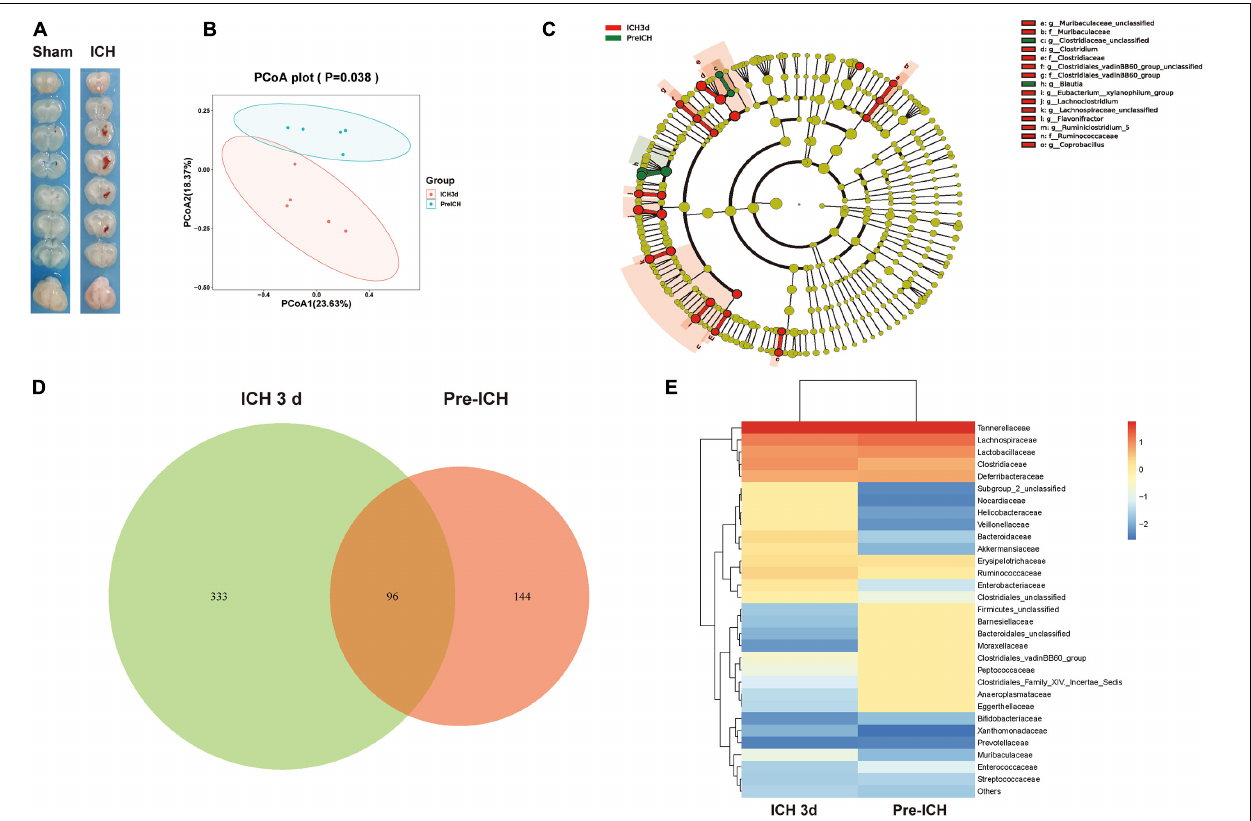
FIGURE 1 | Gut microbiota alterations after intracerebral hemorrhage in mice. (A) Images represented of sham and ICH coronal brain sections 3 days after ICH. (B) Principal coordinates analysis of the gut microbiota by taxonomic abundance patterns in sham and ICH after 3 days mice ( n = 5 per group). (C) Linear discriminant effect size analysis was performed for indicator taxa analysis identifying features that are statistically different between sham and ICH mice ( n = 5 per group). (D) Venn diagram of the number of differentially features in sham and ICH mice after 3 days ( n = 5 per group). (E) Heat maps of the cluster analysis showing the bacterial composition at the family level in sham and ICH mice after 3 days ( n = 5 per